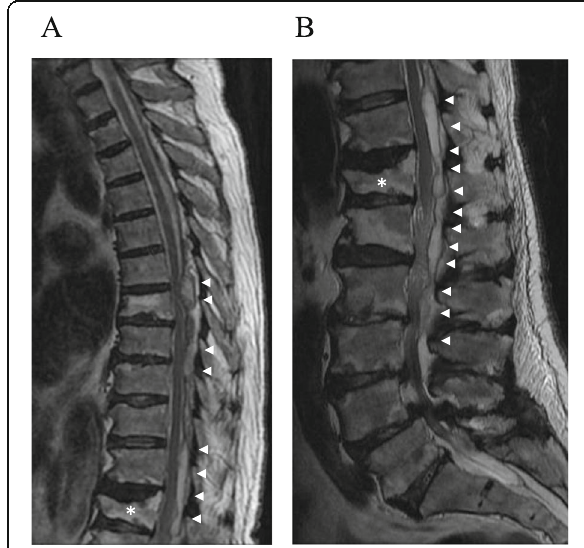
Fig. 1 a , b Magnetic resonance imaging (T2) performed on admission. Fluid retention is observed in the epidural space behind the Th6-L3 spinal canal (arrow). Compression of the spinal cord near Th6/7, Th11/12, and L2/3 due to fluid retention is shown. Vertebral compression fractures can also be seen at Th12 (asterisk)